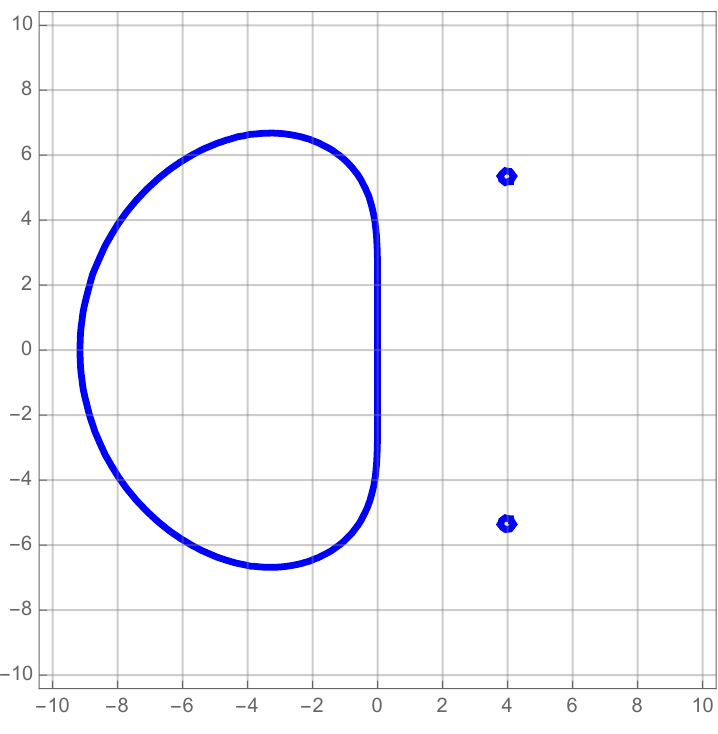
Figure 2. Region of